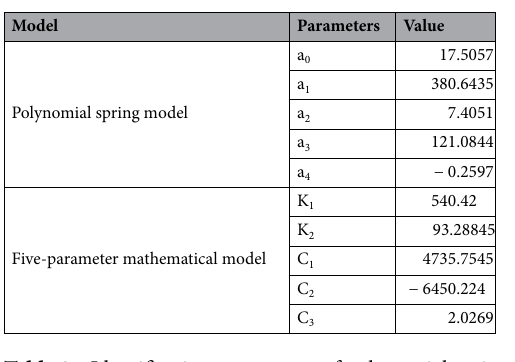
Table 3. Identification parameters of polynomial spring model and FPM model.